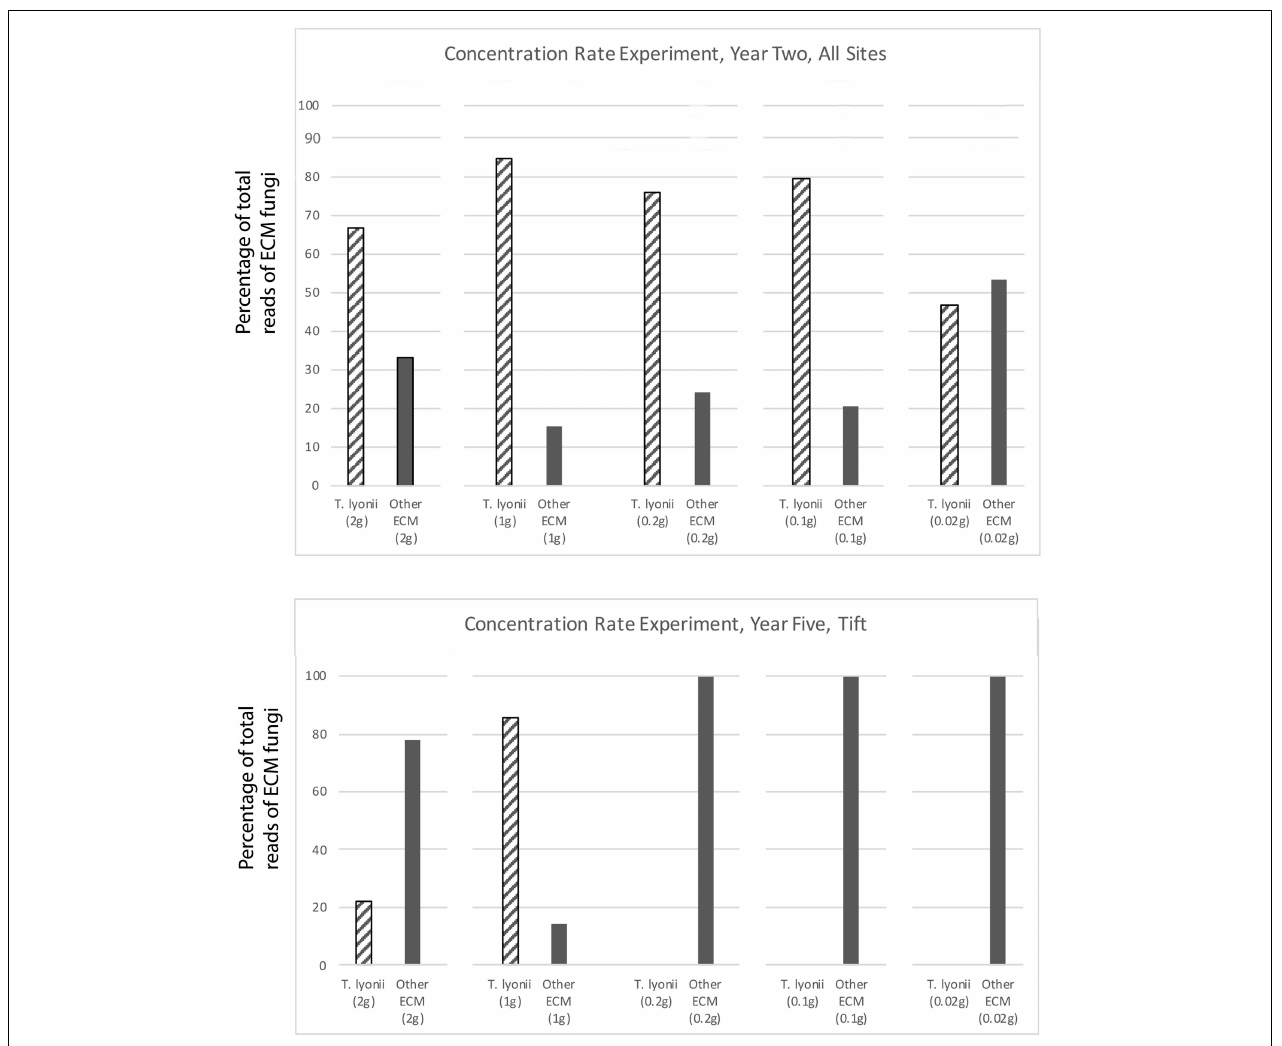
FIGURE 3 | Results of our concentration experiment for year 2 at all sites and for year 5 at the Tift site. This figure depicts the percentage of total sequence reads that were from T. lyonii versus all other ECM fungi in each of the different T. lyonii inoculum treatment levels (2, 1, 0.2, 0.1, and 0.02